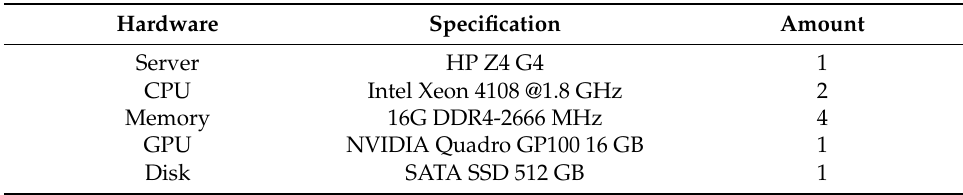
Table 4. UGV modules.